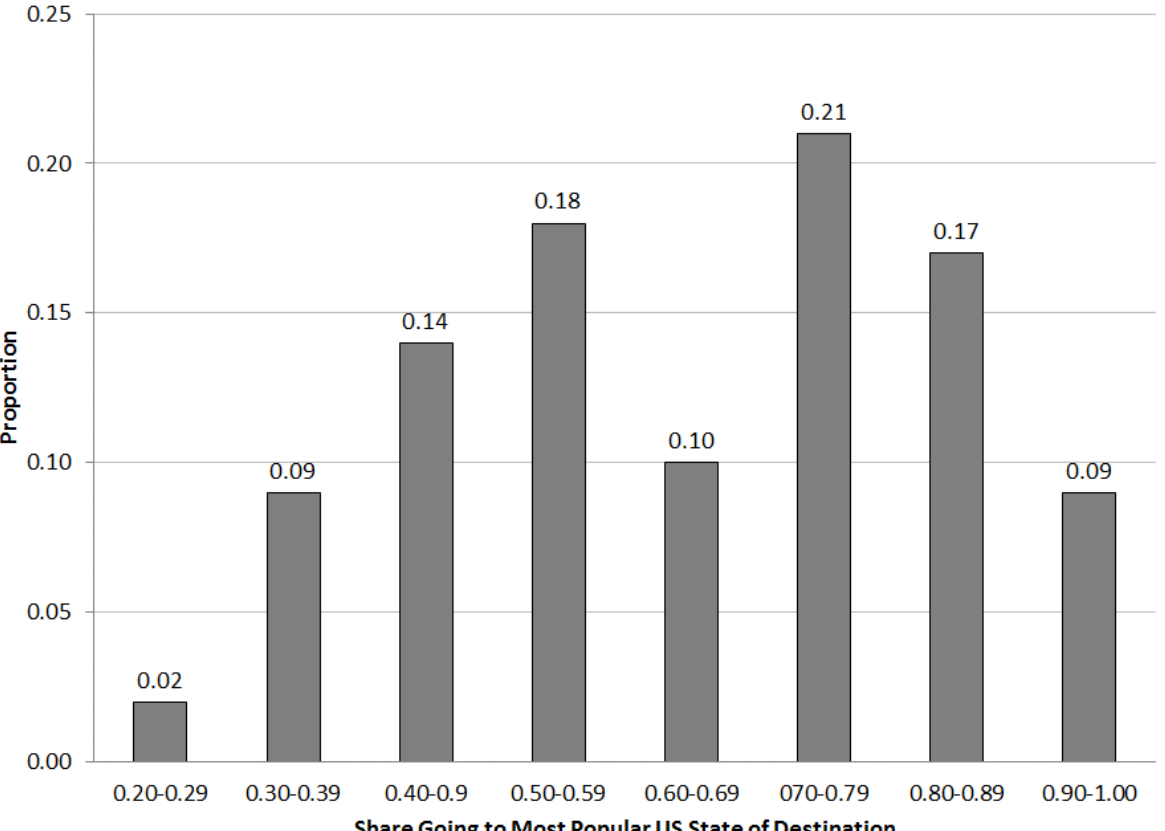
Figure 3. Distribution of communities in the MMP by the share of migrants going to the most popular US state of destination for each